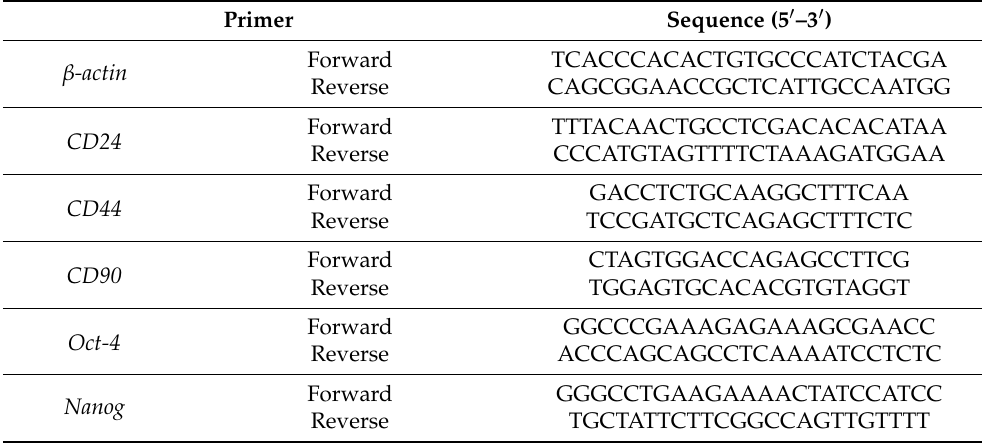
Table 3. Real-time PCR Specific